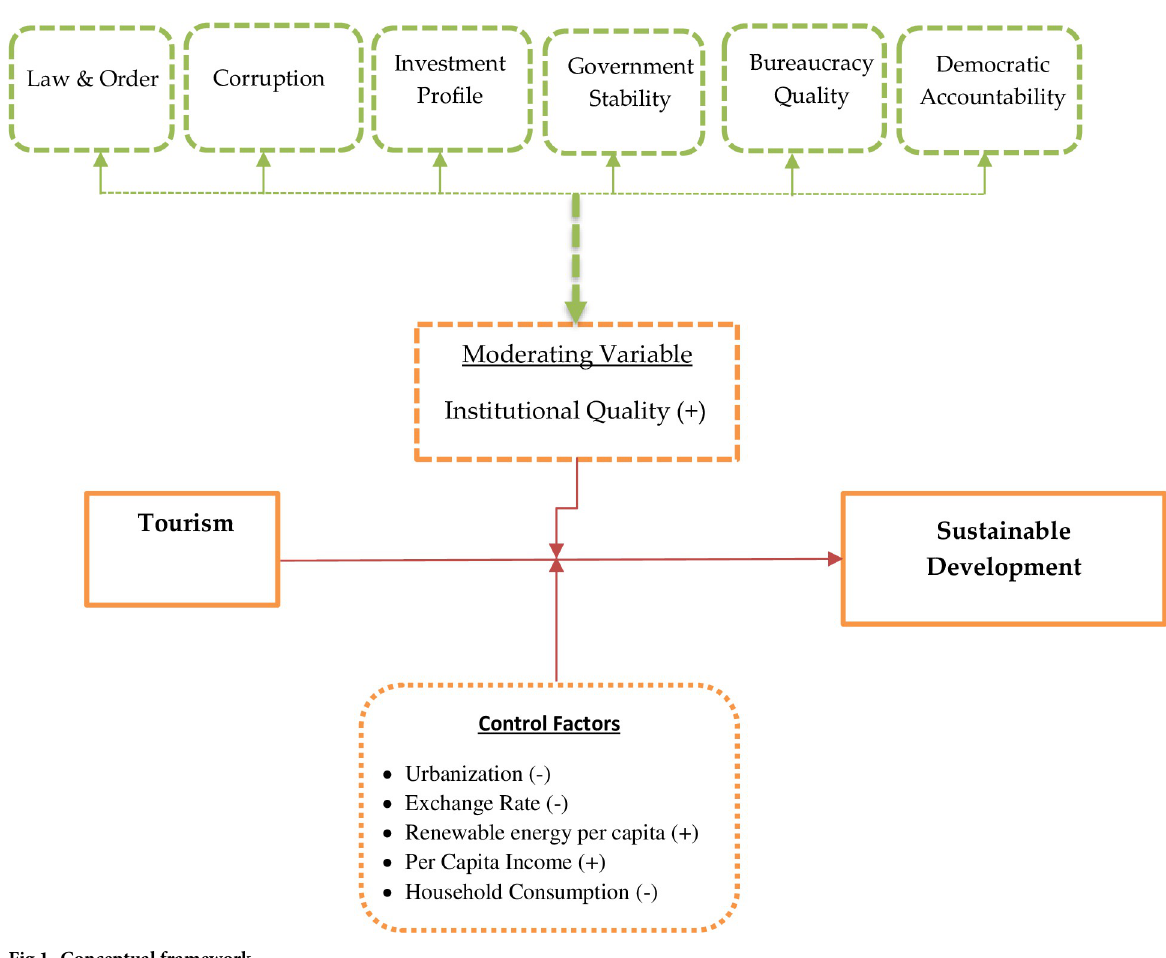
Fig 1. Conceptual